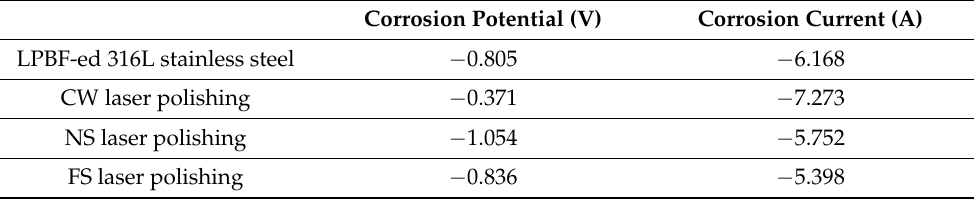
Figure A1. Comparison of polarization curves of initial and laser-polished ( a ) P-SS and ( b ) SS. Table A1. Quantitative information of P-SS samples before and after laser